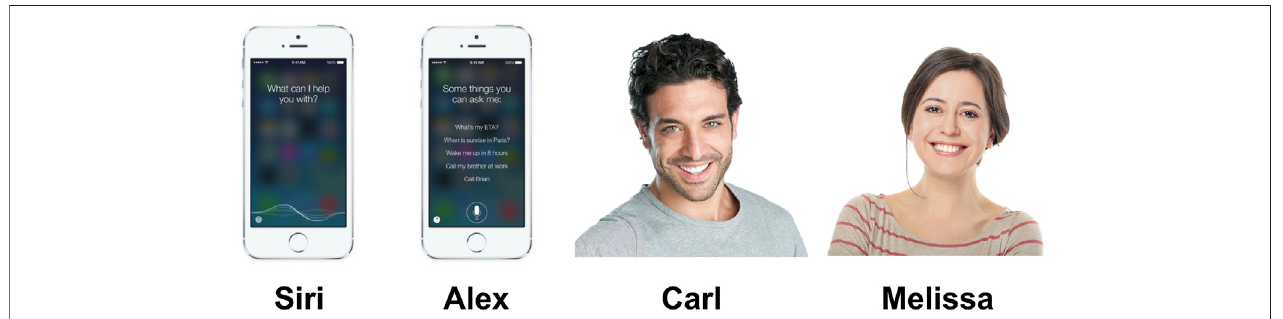
FIGURE 1 | Pictures used correlating to the human and device model